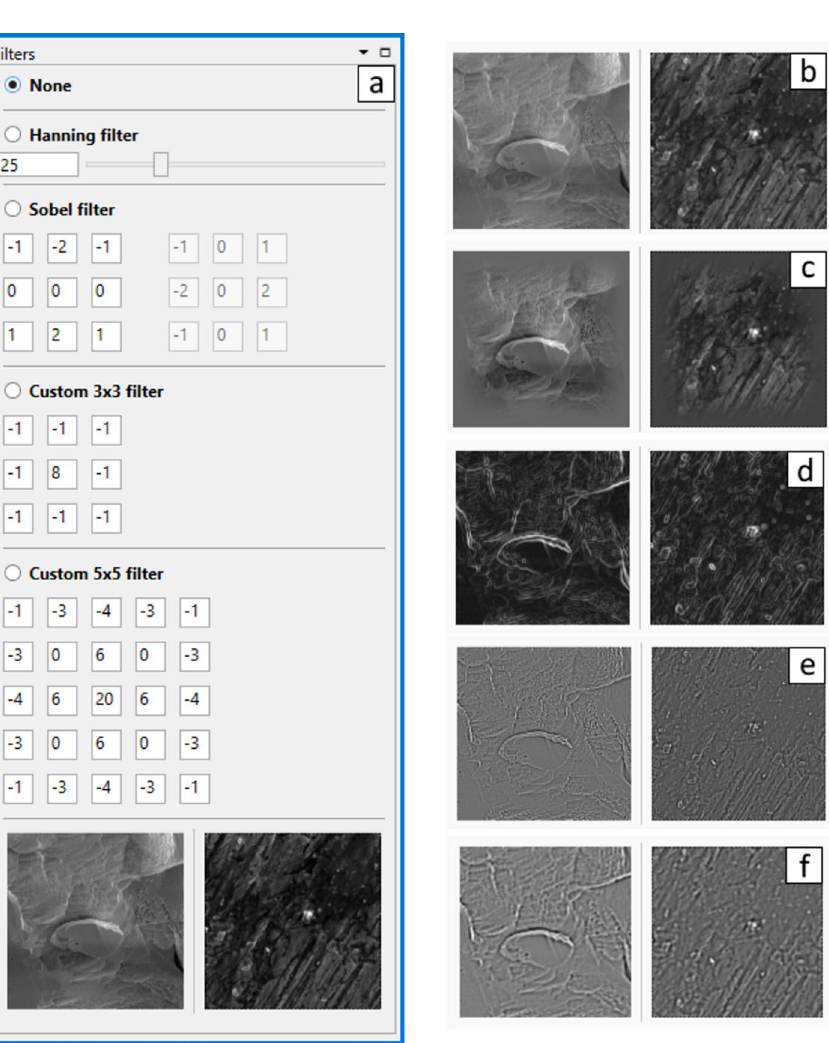
Figure 13. ( a ) Image filters panel; ( b – f ) ROIs on the cutting tool (left) and on the workpiece (right) processed by different filters—( b ) without image filtering, ( c ) Hanning filter, ( d ) Sobel filter, ( e ) 3 × 3 kernel high pass filter, ( f ) 5 × 5 kernel high pass